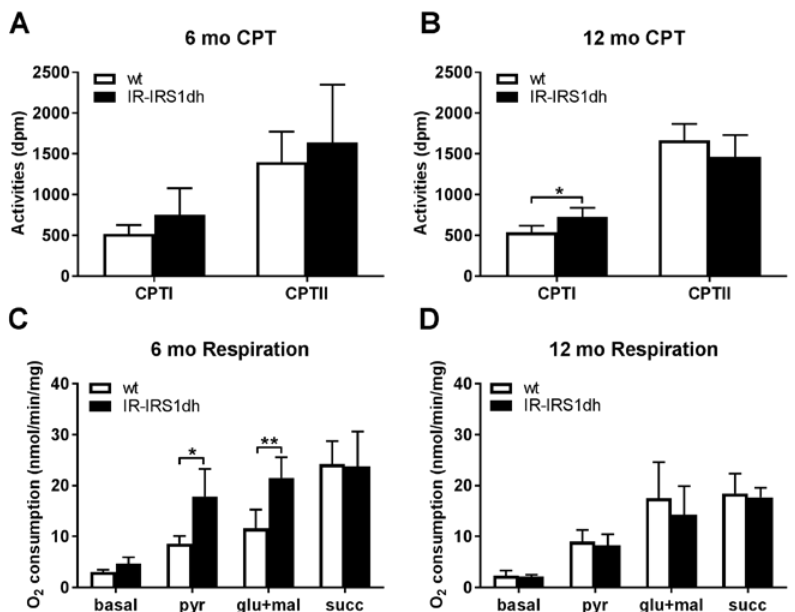
Figure 3. Skeletal muscle mitochondrial performance of IR-IRS1dh mice. ( A , B ) Carnitine palmitoyl transferase activities (CPT I and II) measured in skeletal muscle homogenates. ( C , D ) Mitochondrial respiration determined in soleus muscle. pyr: pyruvate; glu: glutamate; mal: malate; succ: succinate. Pyruvate and glutamate were used as complex I substrates, succinate as complex II substrate. Columns represent mean values ± standard deviation; n : 4–6; * denotes significant differences between IR-IRS1dh mice compared to wt controls; * p < 0.05, ** p < 0.01.